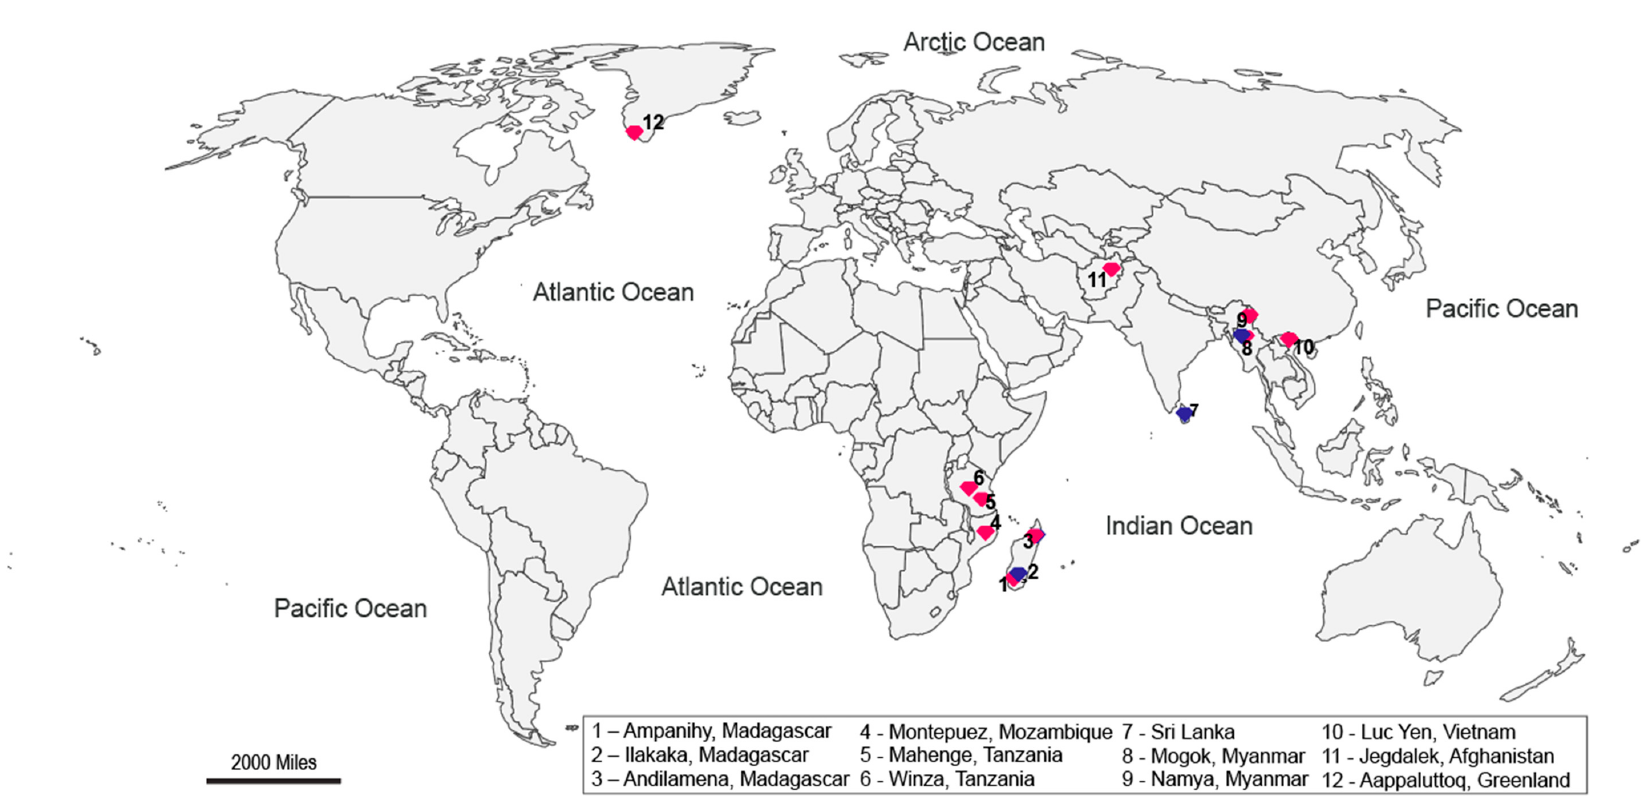
Figure 1. World map showing the 11 localities of origin for ruby (pink symbols) and blue sapphire (blue symbols) analyzed in this study. Also shown is a 12th locality, Greenland. Data of rubies from this locality [12] are included in the discussion.